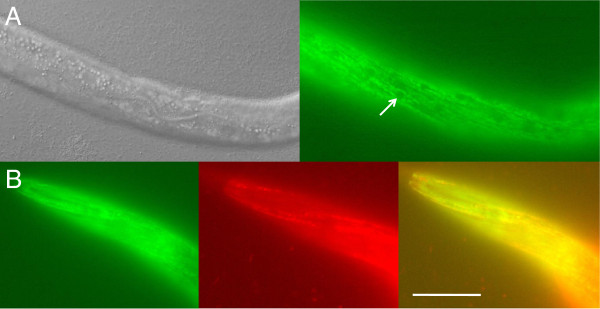
oxa-1::gfp expression pattern. A, B: Transgenic strain AW241 (ouEx609 (pAW318 + rol-6-)), where pAW318 is a translational GFP fusion of oxa-1 driven by the endogenous promoter. oxa-1 is expressed at a high level throughout the worm in a reticular mitochondrial network pattern characteristic of mitochondrial proteins. A: expression of oxa-1::gfp is particularly strong in body wall muscle cells, where it is excluded from the nuclei (white arrow). B: co-localization of oxa-1::gfp (left hand green image) and Mitotracker Red (central red image) in the merged image (right hand yellow image), confirming expression of oxa-1::gfp in mitochondrial networks. Scale bar, 100 μm. Anterior is to the left in all images.